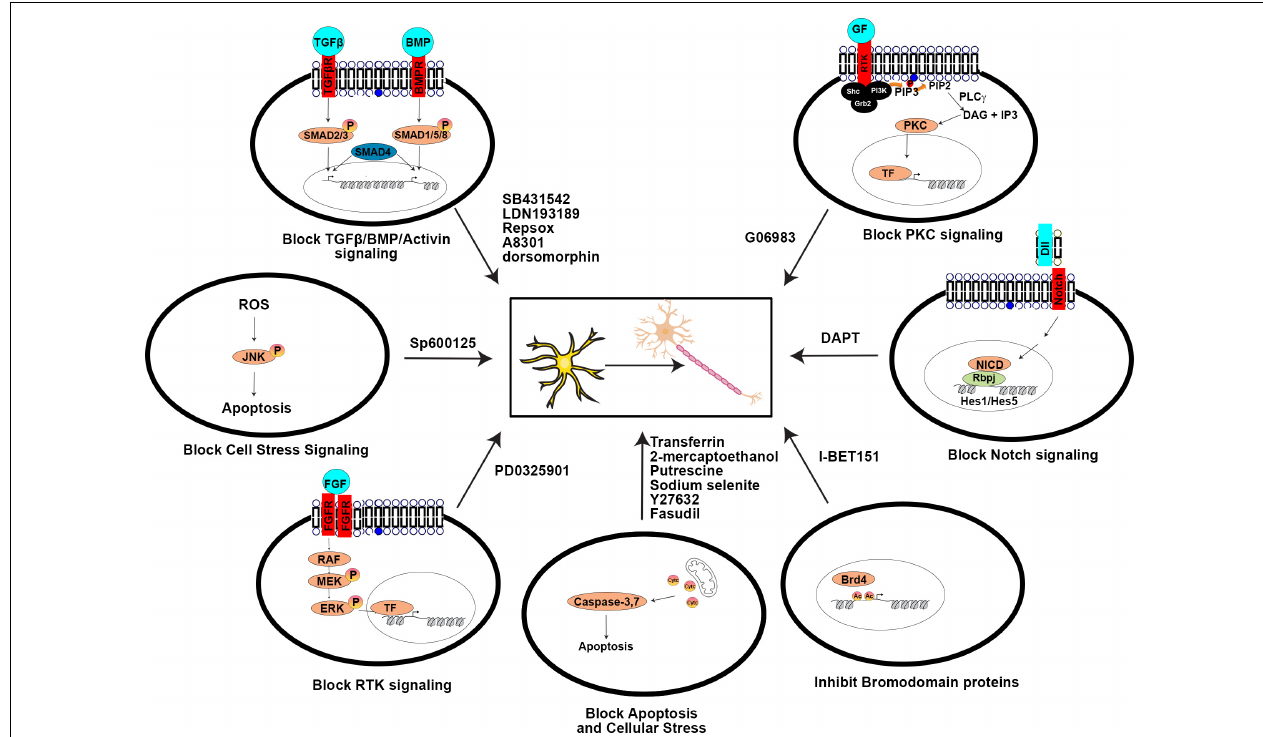
FIGURE 4 | Signaling pathways blocked by small molecules to aid direct neuronal reprogramming. A summary of the agonists/antagonists used in neuronal reprogramming cocktails that inhibit critical signaling pathways or cellular